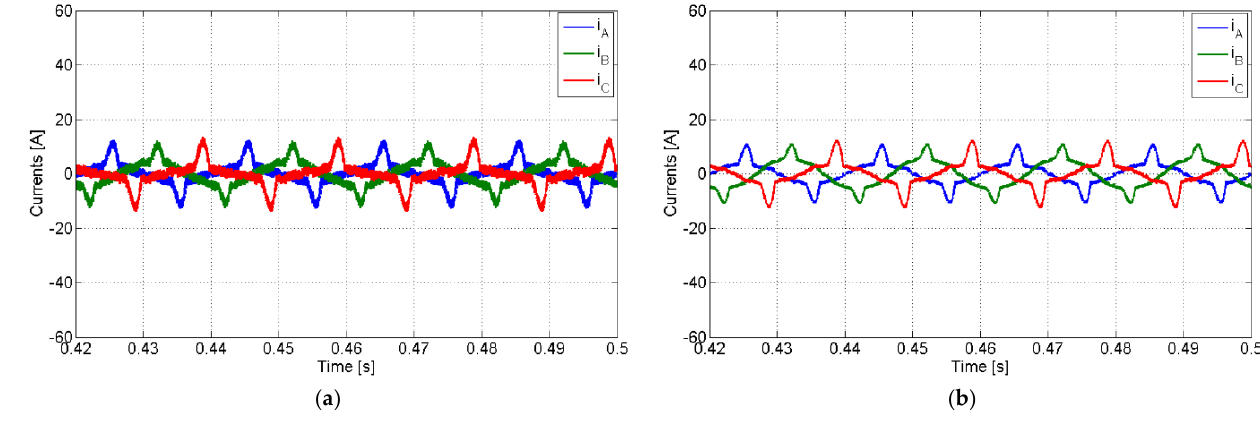
Figure 20. Simulation results with the PV generator in subcompensation mode with a non-linear load and for compensation of the reactive power and harmonics: ( a ) AC currents of the PV generator; ( b ) grid currents.